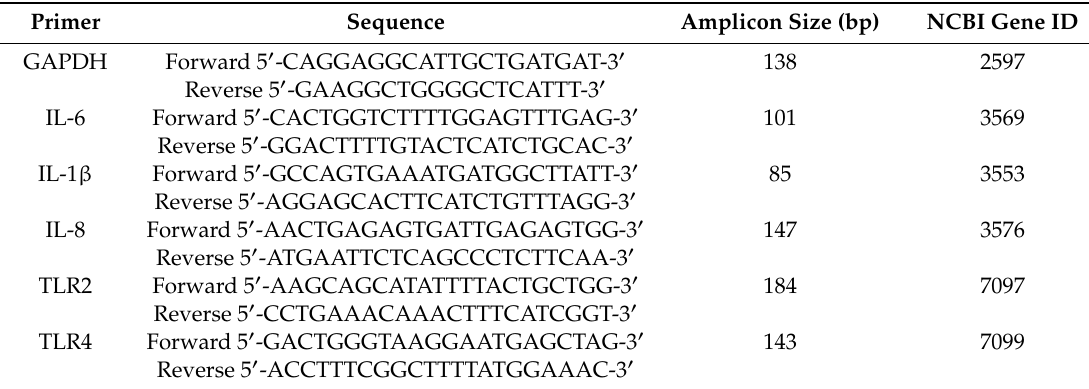
Table 1. Oligonucleotide Primers Used for